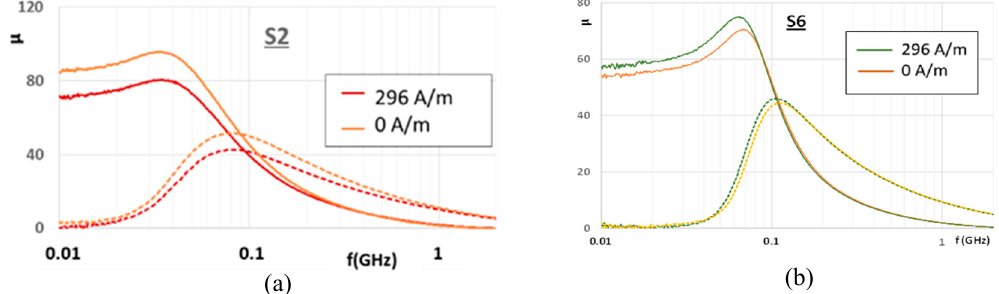
Figure 8. Permeability variations of ( a ) S2 sample and ( b ) S6 sample as a function of the frequency of the HF field, for two intensities of the DC field (insert: the values of the averaged DC field over the sample, limited here to 3.7 Oe, i.e., 296 A / m.) Real and imaginary parts are full and dashed lines, respectively .